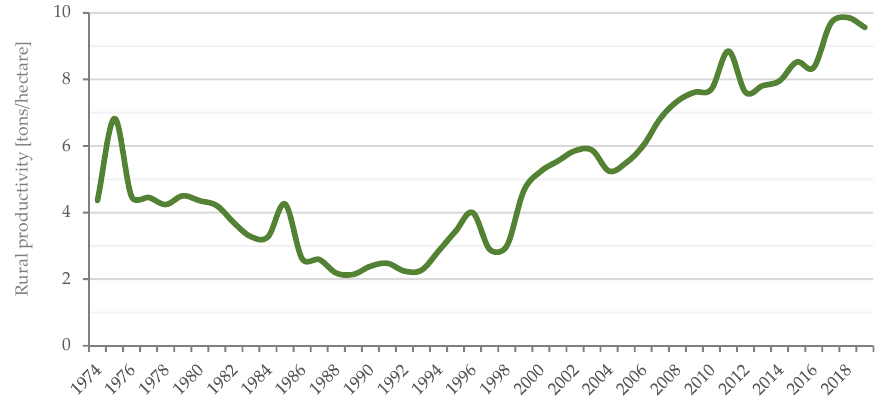
Figure 4. Rural productivity (ton/ha) data between 1974 and 2019 (Source: prepared by the authors based on data from IBGE).